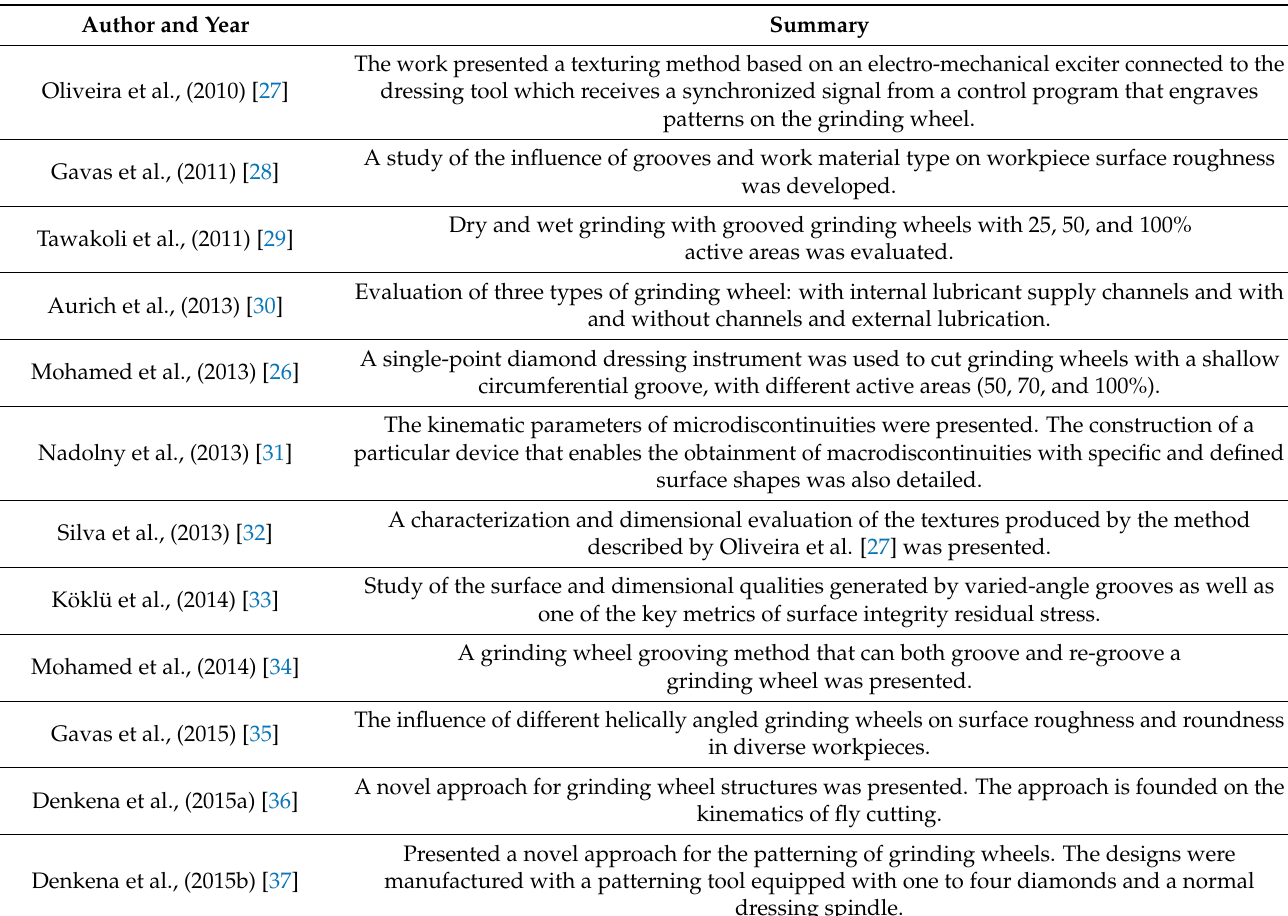
Table 1. Summary of publications on machined grooves.